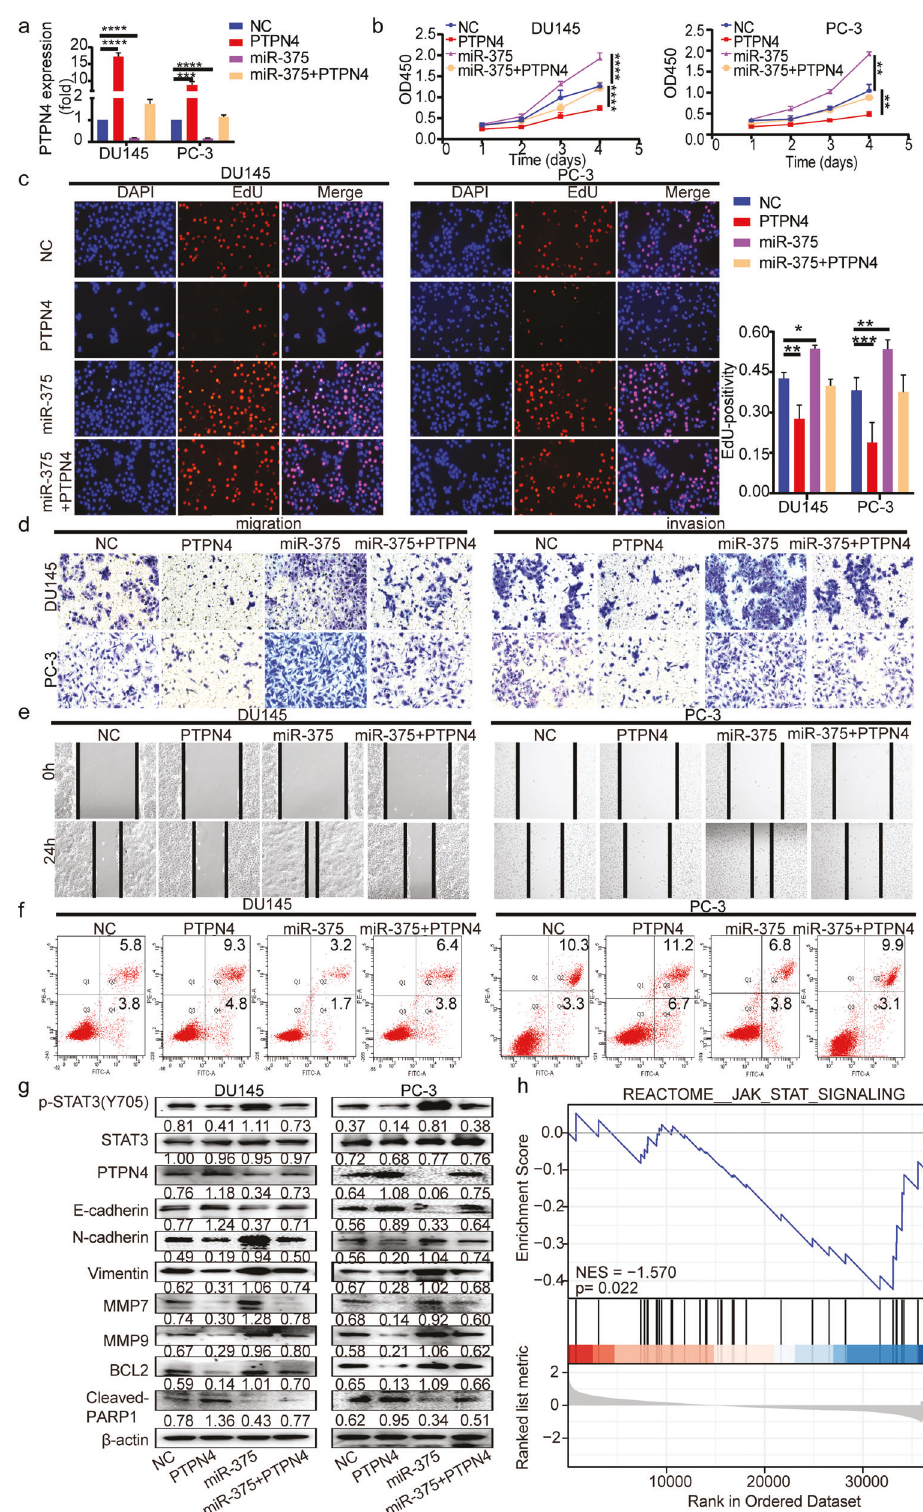
directly targeted and inhibited these three genes. Of note, PTPN4 was suppressed in prostate cancer tissues in the UALCAN database (Fig. 3d), which was negatively correlated with miR-375 expression, as illustrated in StarBase (Fig. 3e). Other than PTPN4, no statistical signi fi cance was found regarding EIF4G3 or UBE3A expression when prostate cancer tissues were compared